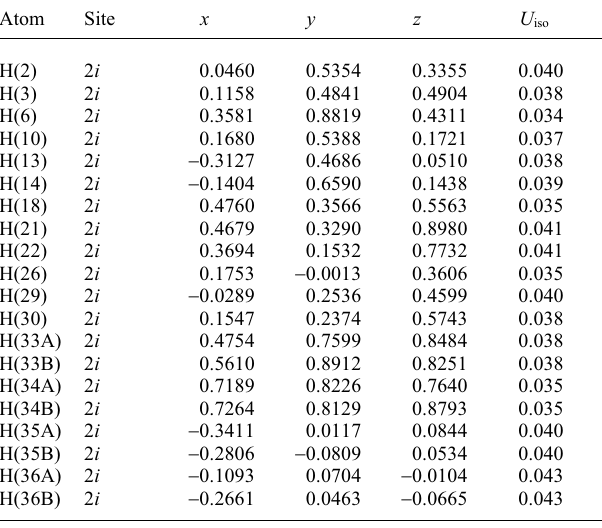
Table 2. Atomic coordinates and displacement parameters (in Å 2 )